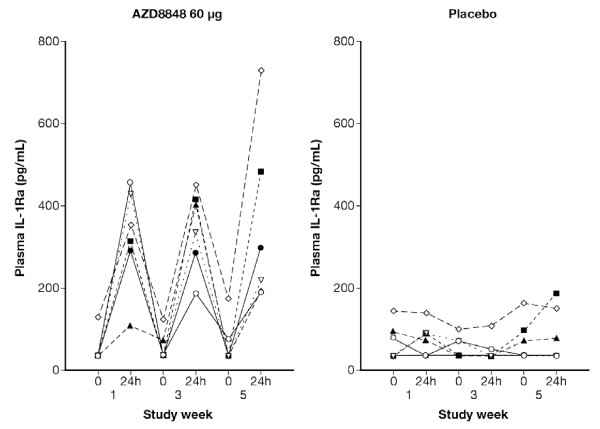
IL-1Ra in plasma obtained at Study weeks 1, 3, and 5 from the repeat challenge/treatment study (symbols indicate individual values: n = 6). IL-1Ra increased 24 hours after nasal administration of AZD8848 and the effect was consistent and repeatable (p < 0.001).